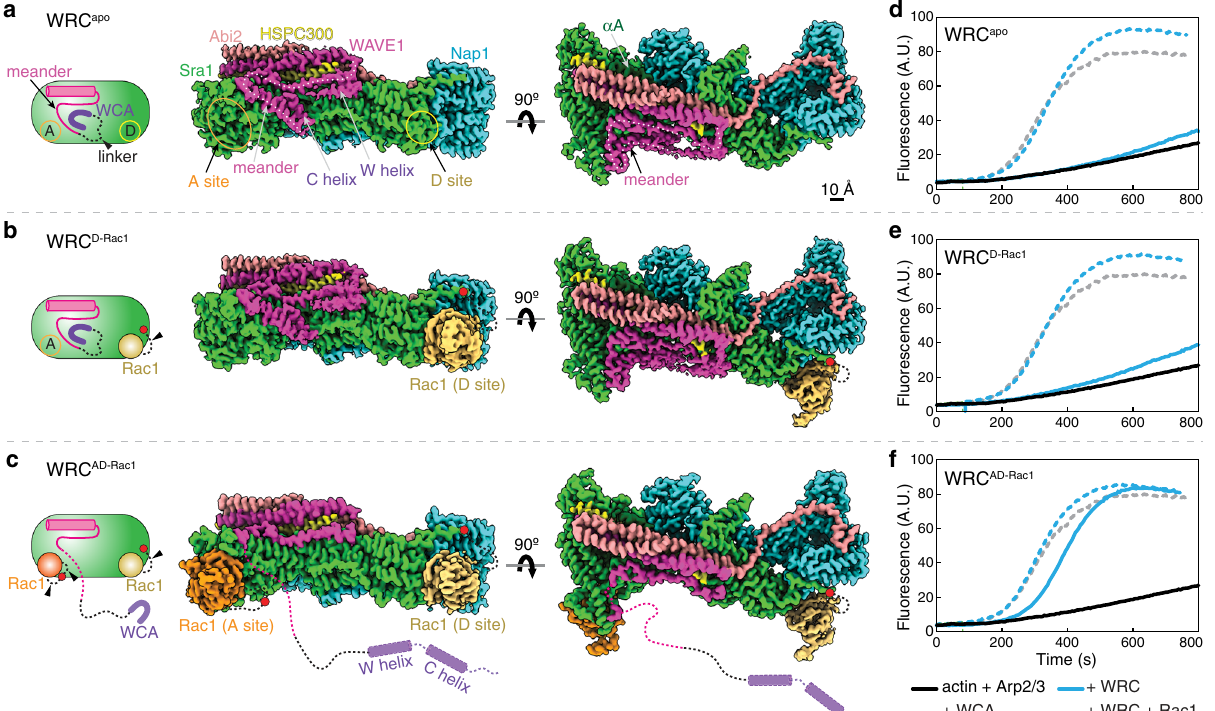
Fig. 1 | Cryo-EM structures of the WRC in different Rac1-bound states. a – c Schematic and cryo-EM density of the indicated WRCs. Black dotted lines indicatedbyarrowheadsare fl exiblepeptidelinkerstetheringRac1totheWRC.The meandersequenceistracedbywhitedottedlines.Otherdottedlinesandcylinders in the WRC AD-Rac1 structure refer to sequences of which the densities are not observed in WRC AD-Rac1 , but present in WRC apo and WRC D-Rac1 . Red dots indicate